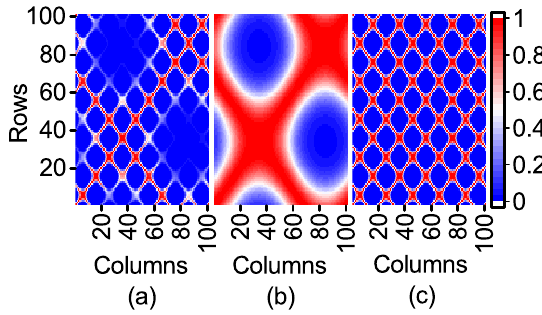
Figure 2. Three 2D heat-maps of kernel matrices: ( a ) kernel matrix generated by two features; ( b ) kernel matrix generated by Feature 1; ( c ) kernel matrix generated by Feature